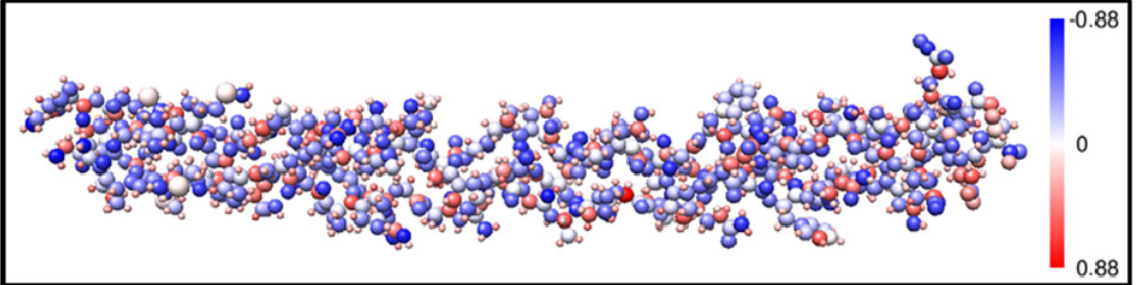
Figure 10. (Color on-line) Partial charges on each atom in the 7-2 heterostructural model using. The size of the atoms is based on covalent radii used to compute an available surface area for the atom’s partial charge. Partial charge is negative (positive) for a gain (loss) in fractional electron charge and colored blue (red). White color indicates no charge transfer for the atom.